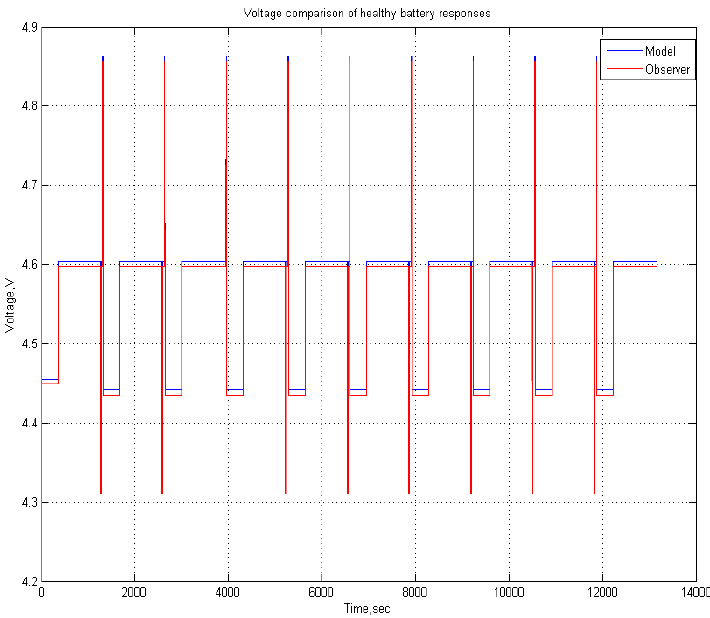
Figure 4. Model and observer response differences for healthy operating of battery.